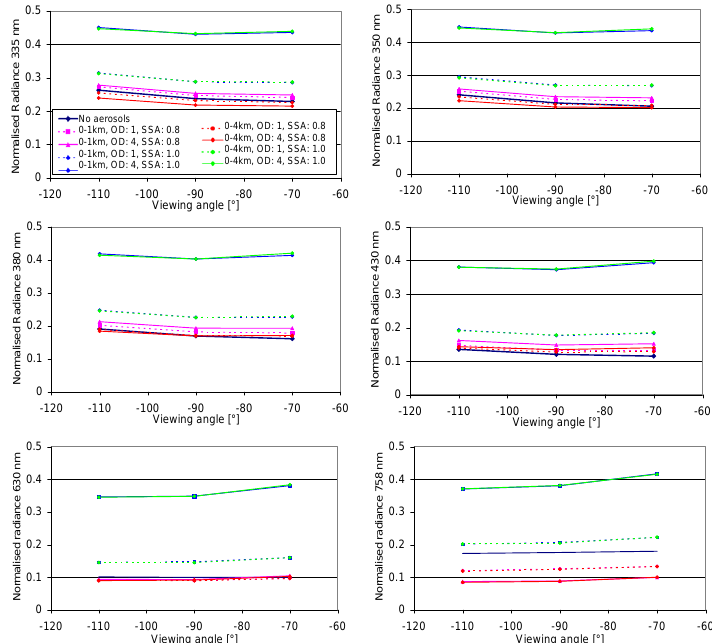
Fig. A3 Dependence of the normalised radiances on the viewing zenith angle of the satellite instrument (angles larger than -90° indicate eastern direction). The calculations are performed for SZA of 30° with the sun in eastern direction. The aerosol asymmetry parameter was assumed to be 0.68. For 758 nm the surface albedo was set to 20%, for 630 nm to 10%, and for all other wavelengths to 5%.